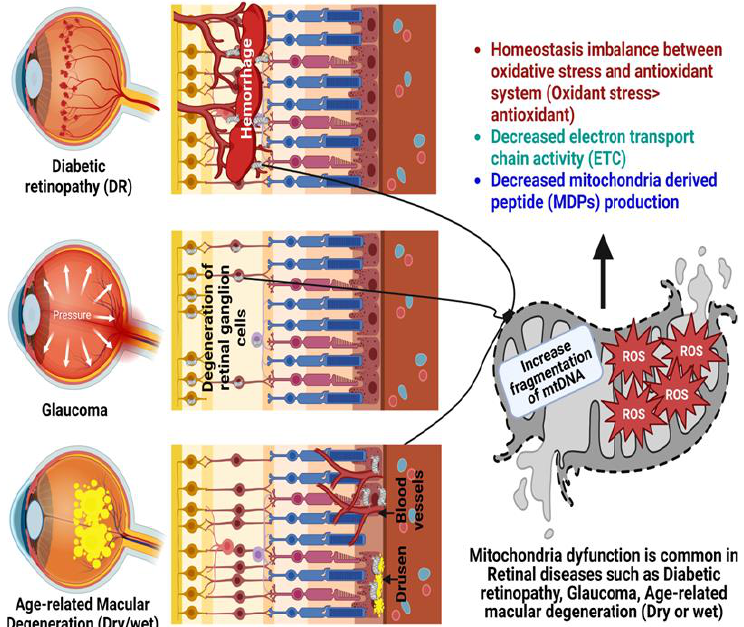
Figure 3. Role of mitochondrial dysfunction in the pathogenesis of glaucoma, diabetic retinopathy (DR), and age-related macular degeneration (AMD) . Created with Biorender.com